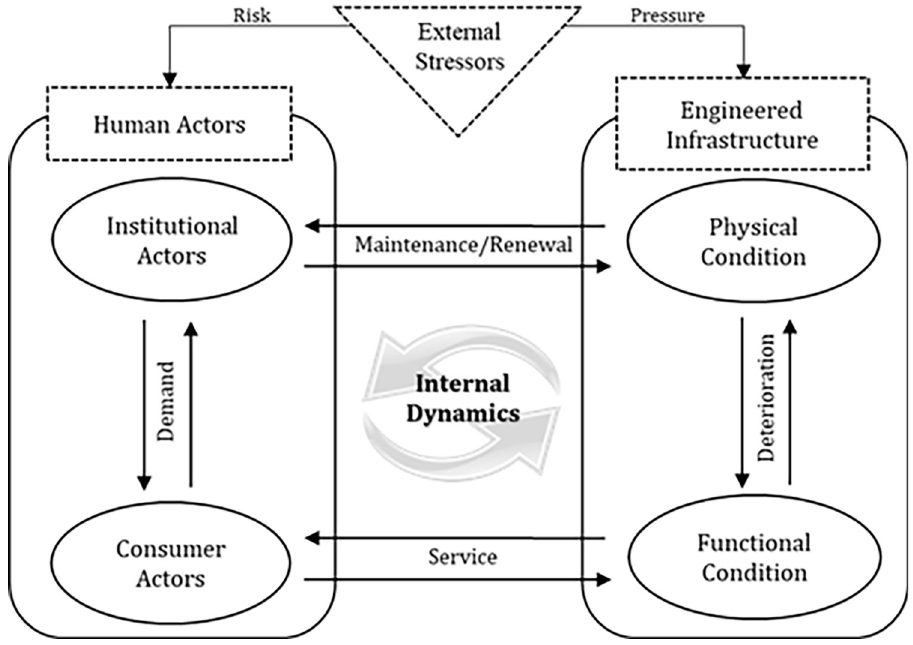
Fig 2. Internal dynamics in complex system of civil